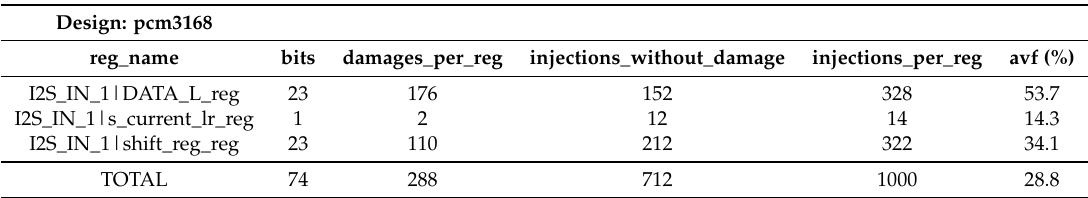
Table 6. Campaign for pcm3168 design.